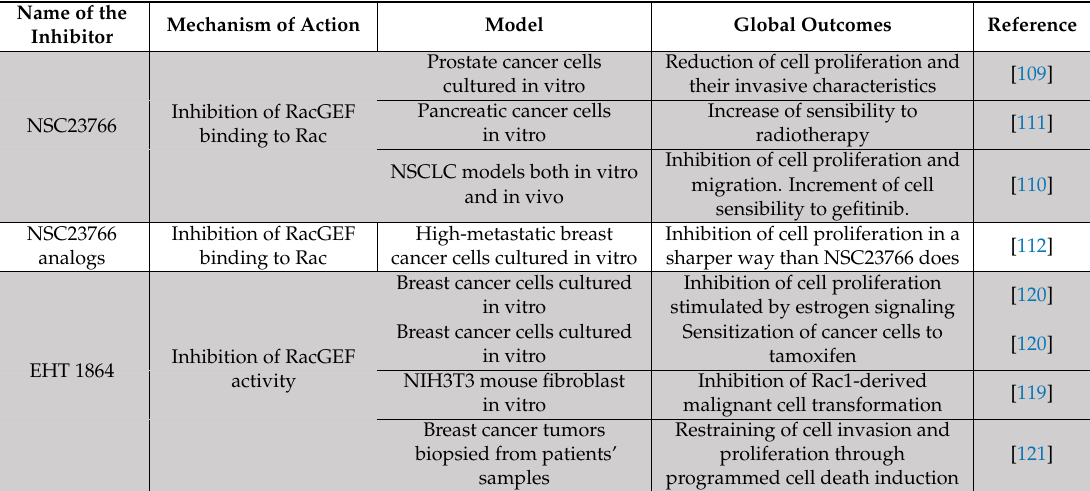
Table 3. Action of Rho and Rab inhibitors in cancer